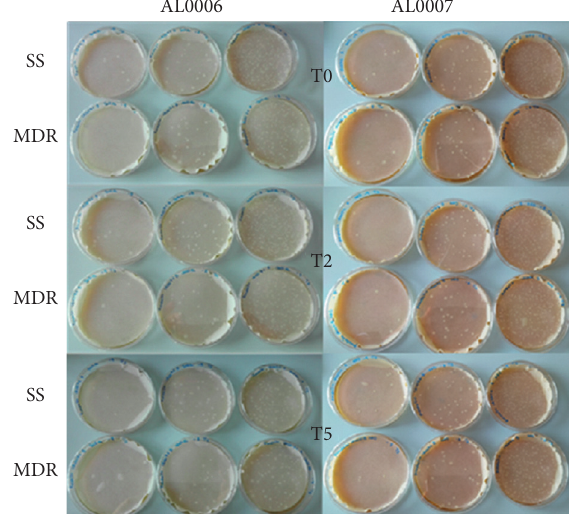
Figure 6: Comparison between the release of bacteria from filter papers added with the two lipogel preparations AL0006 and AL0007 in presence of MRD or SS and measured at different time points (T0: baseline, T2: 2h, T5: 5h).